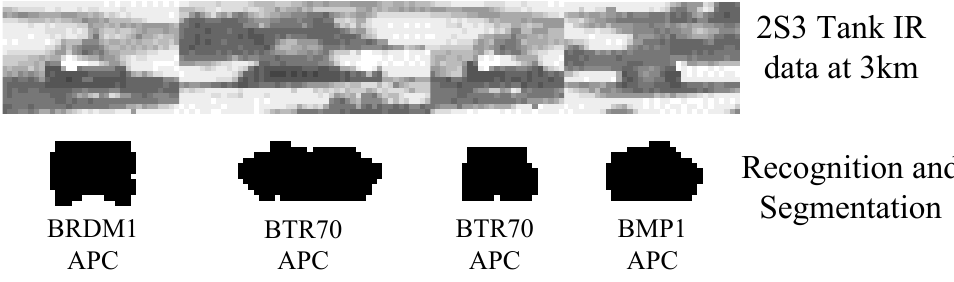
Figure 13. Some failed cases of the 2S3 tank in a day-time sequence at 3 km.